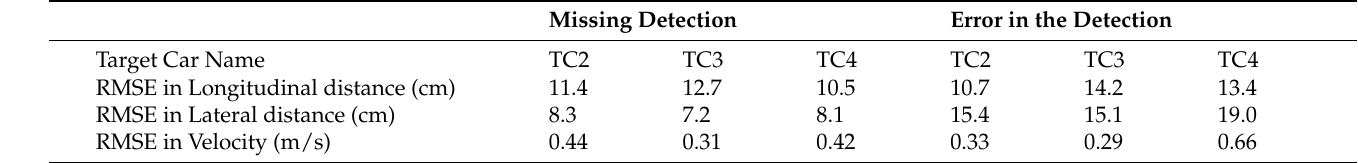
Missing Detection Error in the